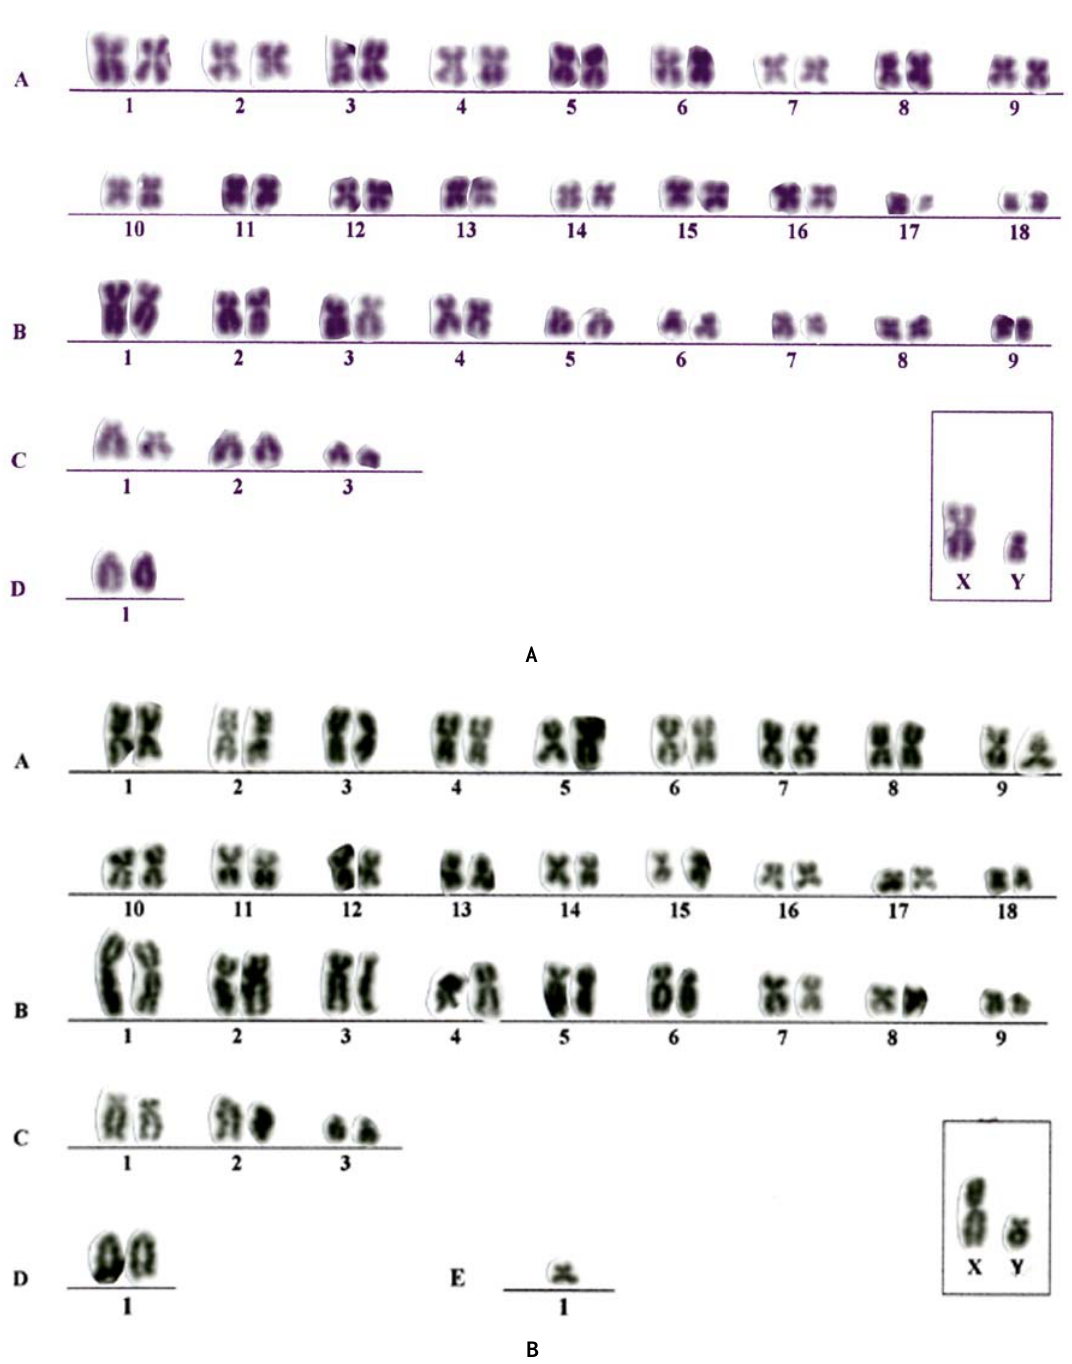
Fig. 1 – Karyotypes of the lineages 2n=64 and 2n=65 (lymphocytes culture) from the male sample (N=277) of D. prymnolopha in conventional Giemsa stain. A) lineage 2n=64; B) lineage